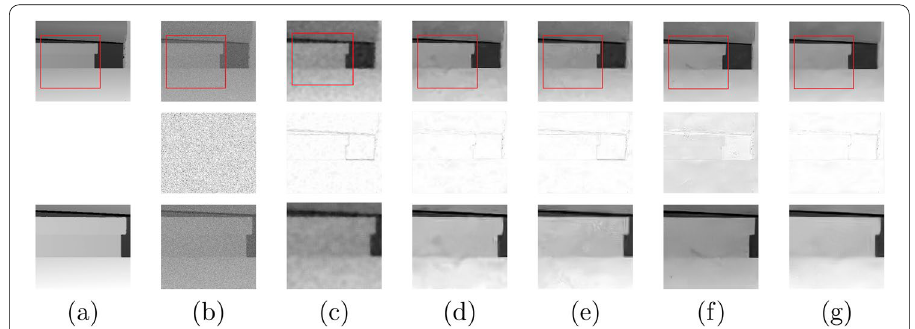
Fig. 4 Denoising results of depth image ( wood ) with the noise variance σ = 50 [top], the difference between the original depth images and the filtered images [middle], and zoom-in image [bottom]. From the left ( a ) to right ( g ) are: the original image, the noisy image, the results obtained by NLM, BM3D, OGLR, ADnet and the proposed method respectively